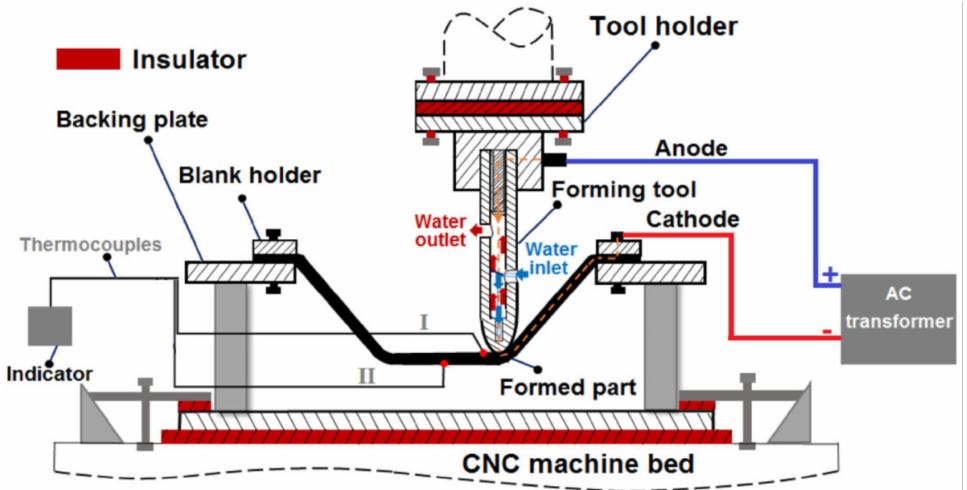
Figure 26. Schematic diagram of resistance SPIF (reprinted with permission from [150]; copyright © 2019, The Indian Institute of